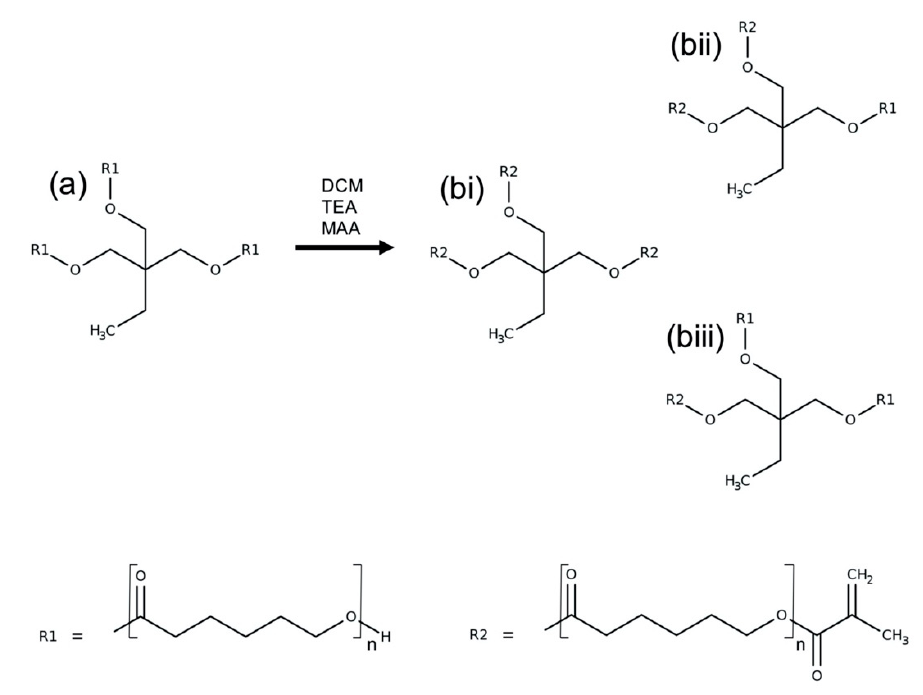
Figure 9. PCL methacrylation reaction scheme. PCL triol ( a ) dissolved in DCM, was reacted with MAA in the presence of TEA to produce three ‐ armed PCLMA ( b ). Depending on the reaction time and the reactant concentrations, the PCL triol could become fully methacrylated, with all three arms expressing a methacrylate group ( bi ) or partially methacrylated ( bii , biii ).